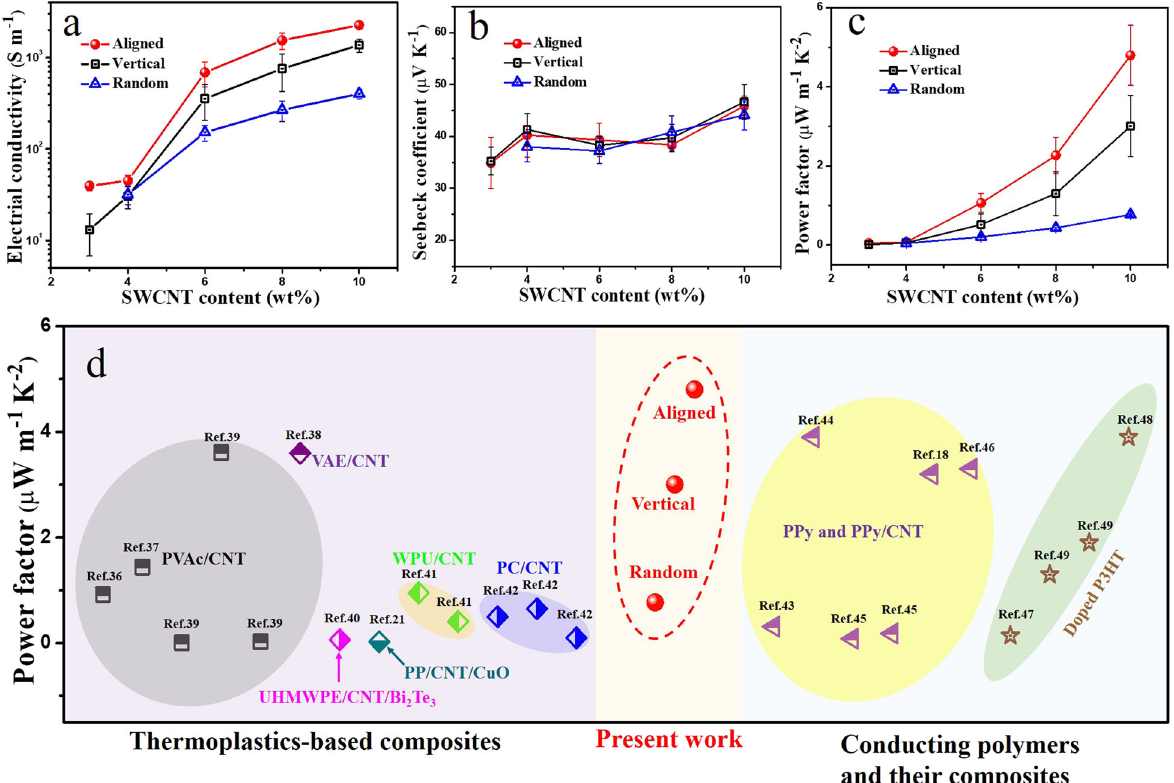
Fig. 2 The performances of TE materials. Dependencies of a electrical conductivities, b Seebeck coef fi cients and c power factors on SWCNT contents for PC/a-SWCNT (along aligned direction and vertical direction to SWCNT alignment) and PC/r-SWCNT composite fi lms. Error bars represent standard deviation with n ≥ 5 for each measurement. d A comparison of power factors of CNT fi lled thermoplastics-based composites 21,36 – 42 , conducting polymers and their CNT fi lled composites 18,43 – 49 . The UHMWPE/CNT/Bi 2 Te 3 composite 40 contains 4 wt% of CNT and 30 wt% of Bi 2 Te 3 and PP/CNT/CuO composite 21 contains 2 wt% of CNT and 5 wt% of CuO. The CNT content of other composites is fi xed at 10 wt%. Abbreviations for the mentioned polymers: PVAc is poly(vinyl acetate) latex, VAE is vinyl acetate and ethylene emulsion, UHMWPE is ultrahigh molecular weight polyethylene and WPU is waterborne